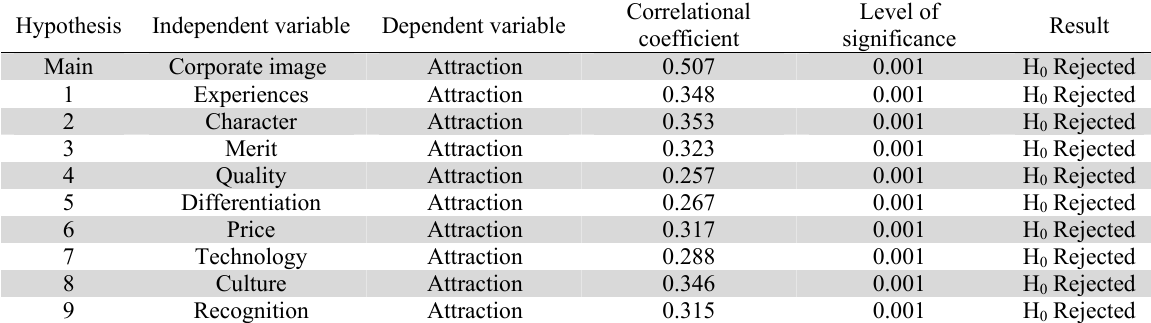
Results of bilateral relation between hypotheses of